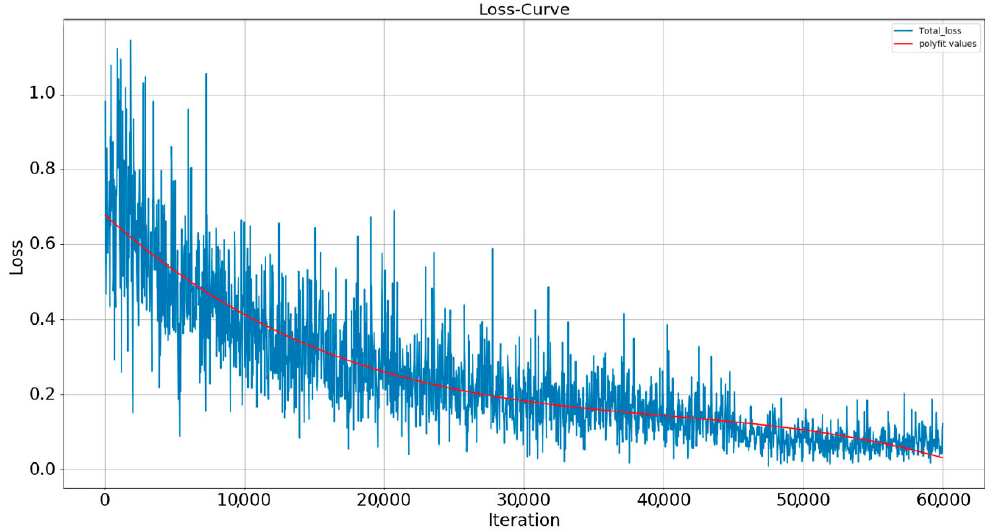
Figure 7. The loss curve and fitted curve of Multi-stage FEPN.